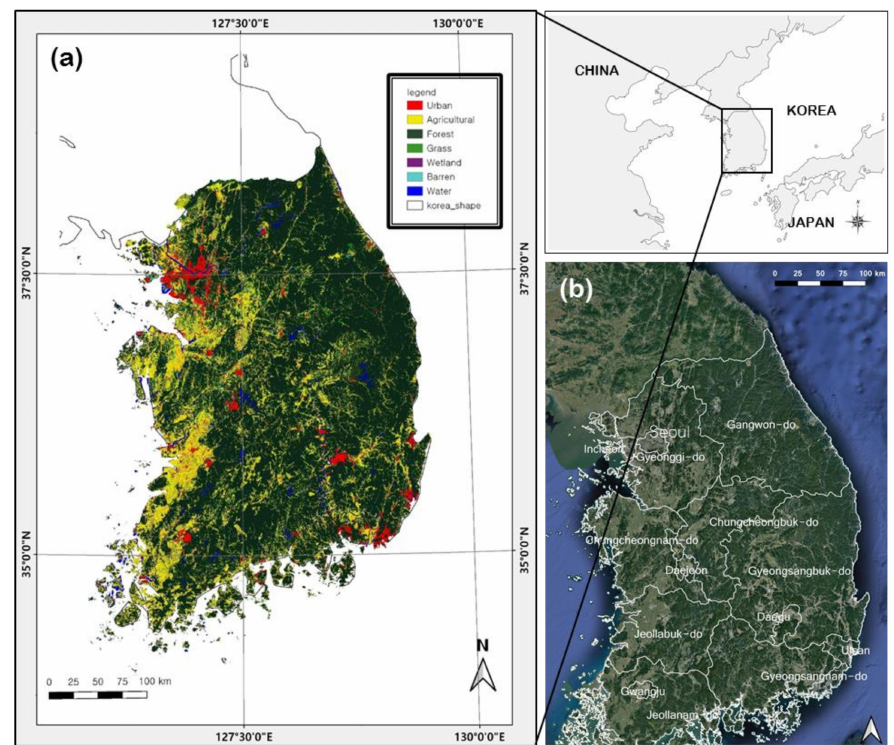
Figure 1. ( a ) The study area and the land cover status; ( b ) a satellite image of the study area showing the 16 regional local